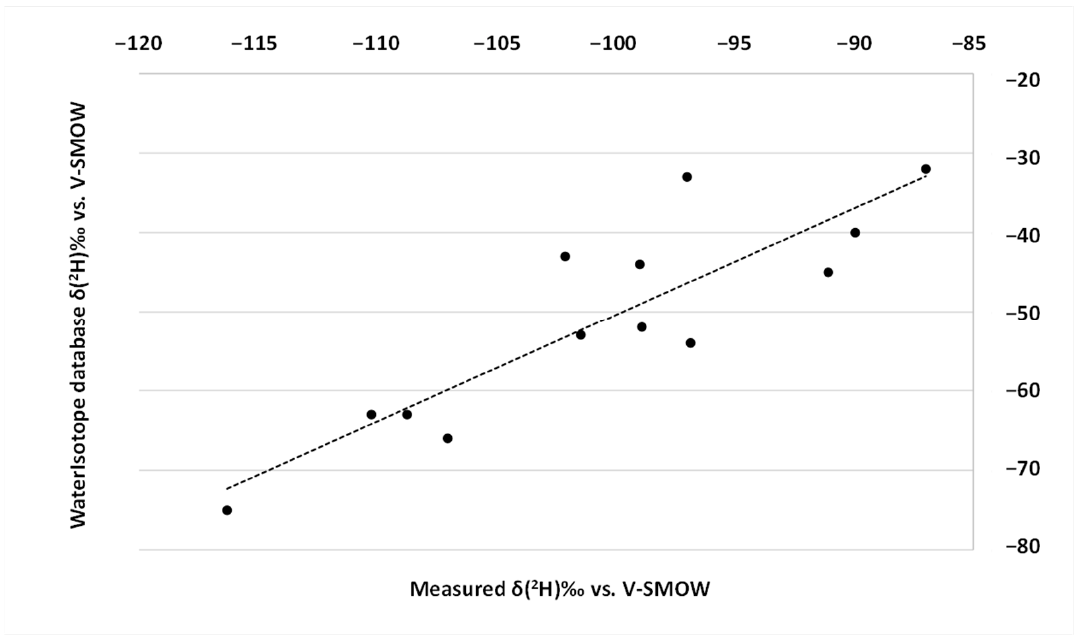
Figure 1. Correlation between annual δ ( 2 H) of water at the beef sampling location estimated by the Water-Isotope database (Oxygen Isotopes in Precipitation Calculator) and the average δ ( 2 H) values measured in the beef protein.